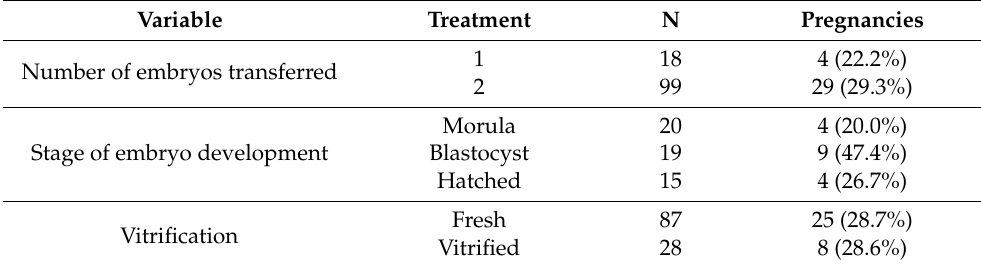
Table 3. Embryo Transfer and Pregnancy